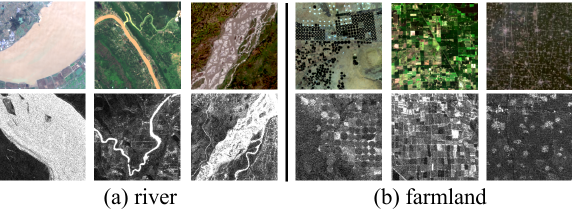
Figure 3 . Large diversity within one category. (a) Multiscale images of the same scene. (b) Different styles of the same scene.